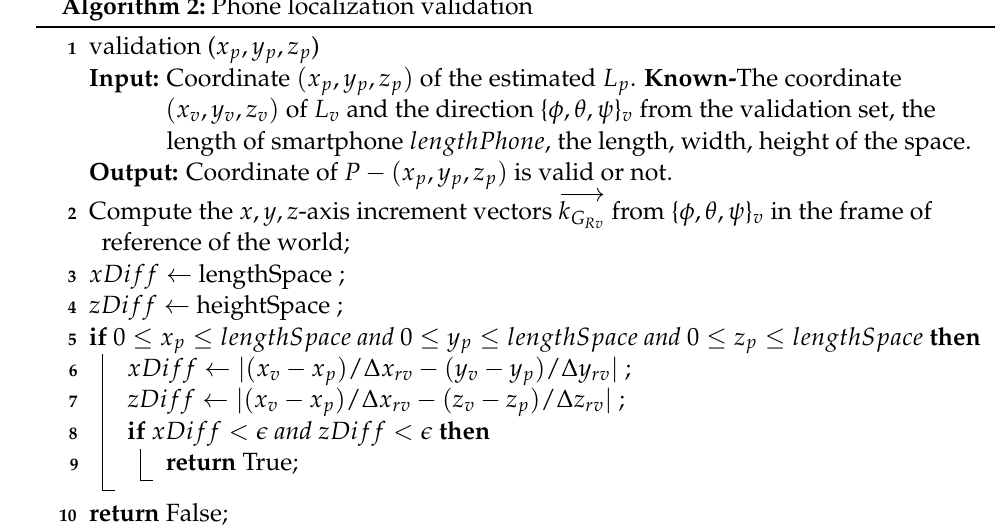
Algorithm 2: Phone localization validation